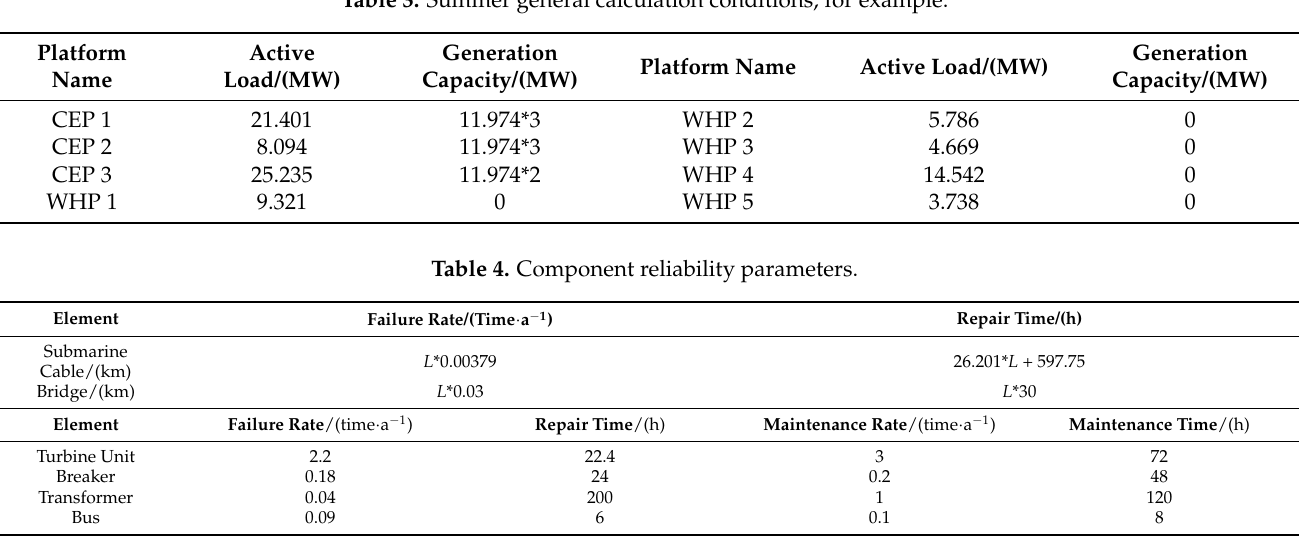
Table 3. Summer general calculation conditions, for example.